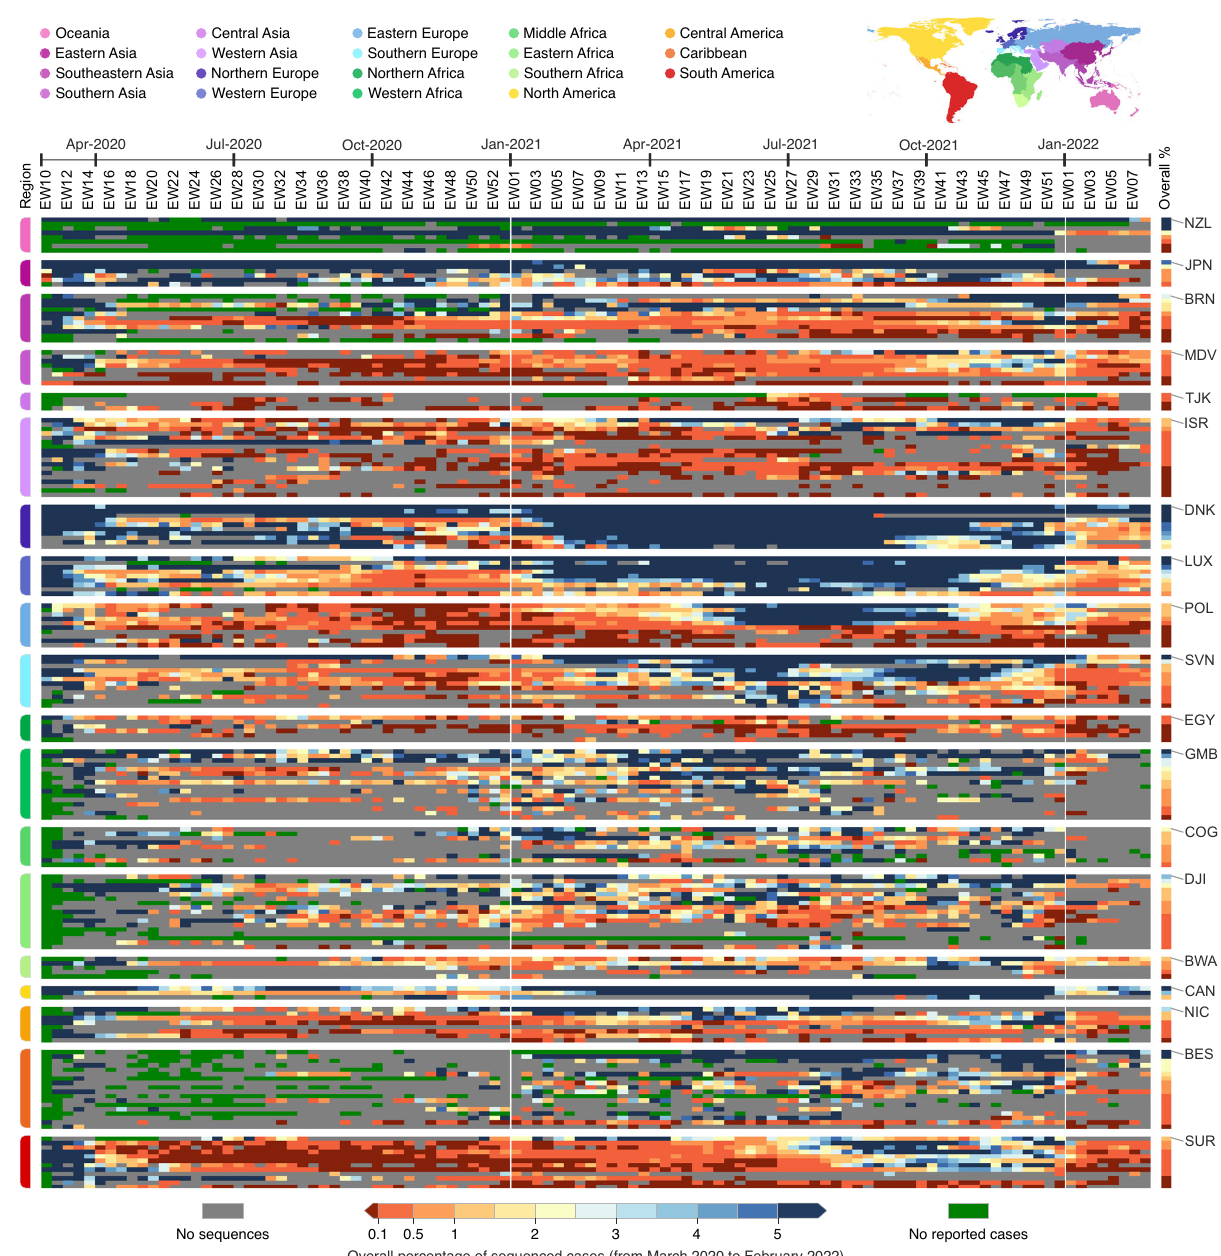
Fig. 1 | Disparities in SARS-CoV-2 global genomic surveillance. Percentage of reported cases that were sequenced per country, per epidemiological week (EW), based on genomes collected from EW 10 of 2020 (March 1st) to EW 8 of 2022 (February 26th), with metadata submitted to GISAID up to March 18th, 2022. Updated numbers on sequence submissions and proportion of sequenced cases are available on the GISAID Submissions Dashboard at “ gisaid.org ” . Countries